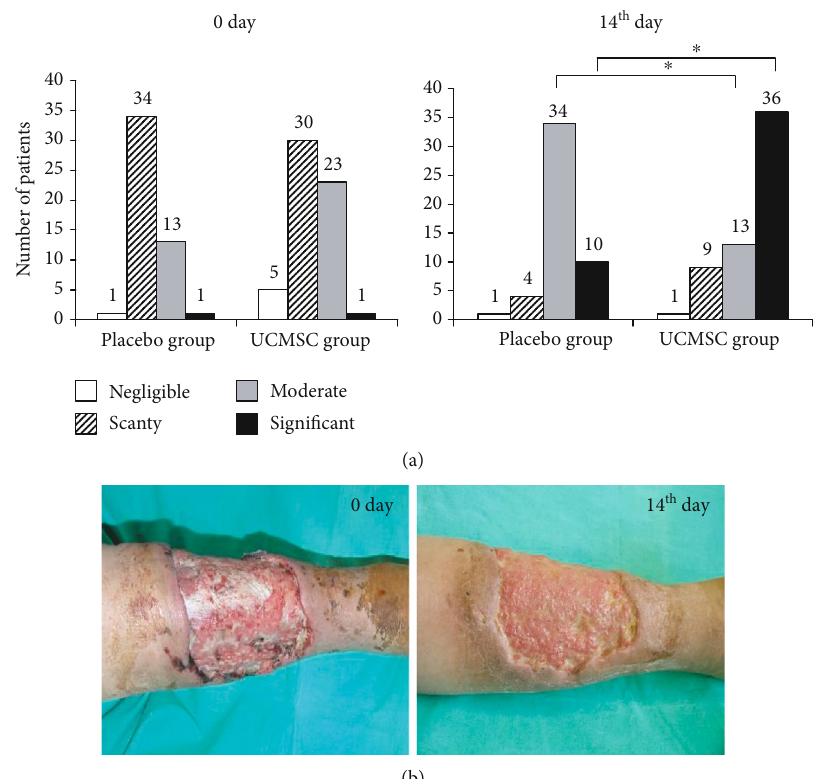
Figure 2: The dynamics of granulation tissue formation in chronic wounds. (a) The qualitative characteristics of granulation tissue in patients of the placebo and UCMSC groups before and 14 days after treatment ( χ 2 test; ∗ reliability of the di ff erences at p < 0 : 05 ). (b) representative images of wounds of the UCMSC group before and 14 days after cell